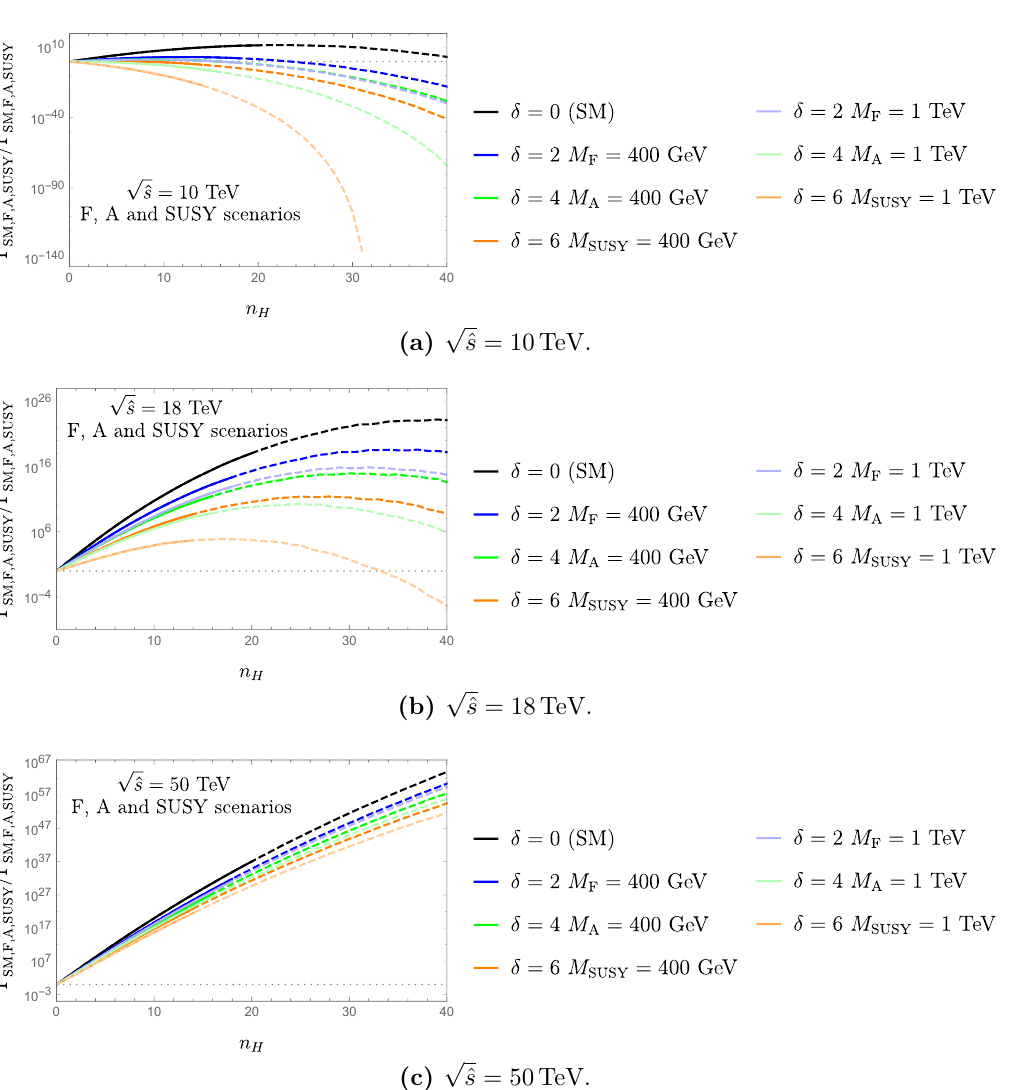
Figure 5. n H distributions for several qq collision energies